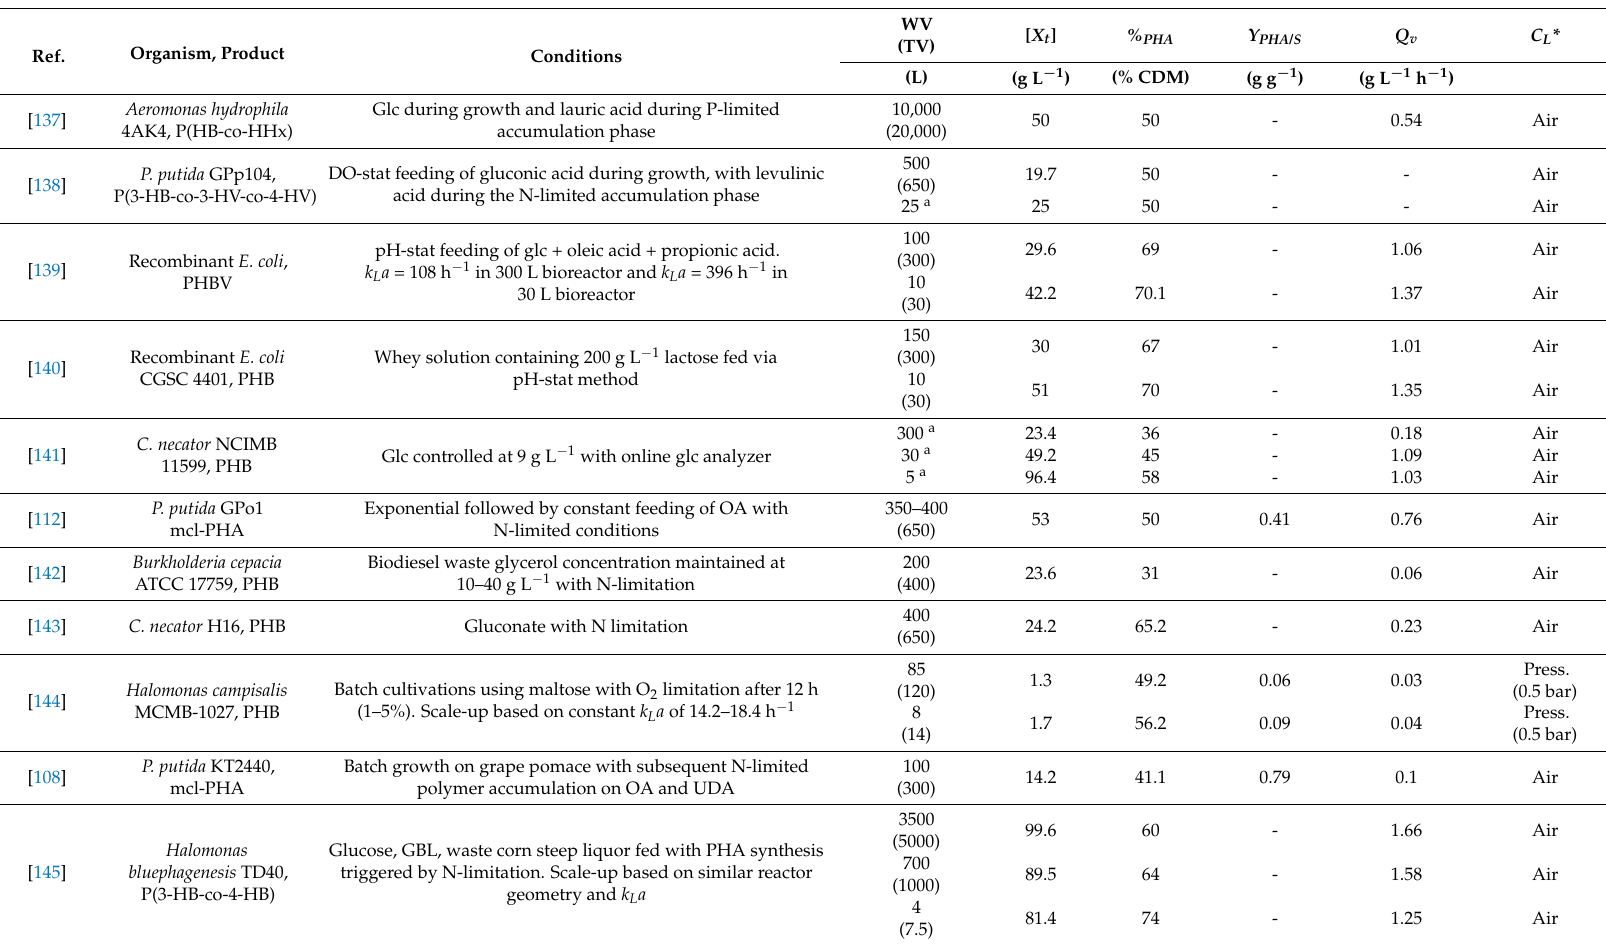
Table 4. Chronological summary of studies that have examined scale-up of various processes for scl-PHA or mcl-PHA production.